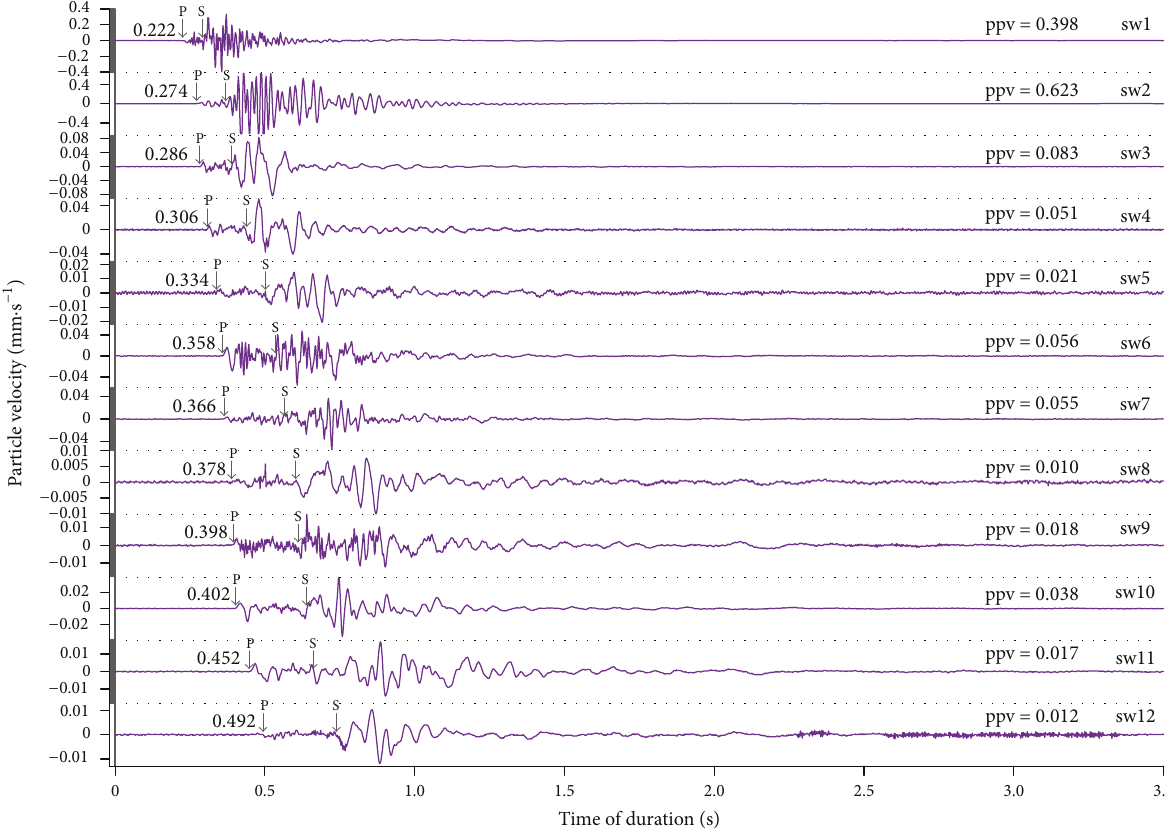
Figure 4: Waveform and basic characteristics of the measured microseismic wave group. Because of the impact of the velocity threshold set initially in the monitoring instrument, the PPV value of wave sw2 is not measured, and the velocity threshold limits the real particle velocity.